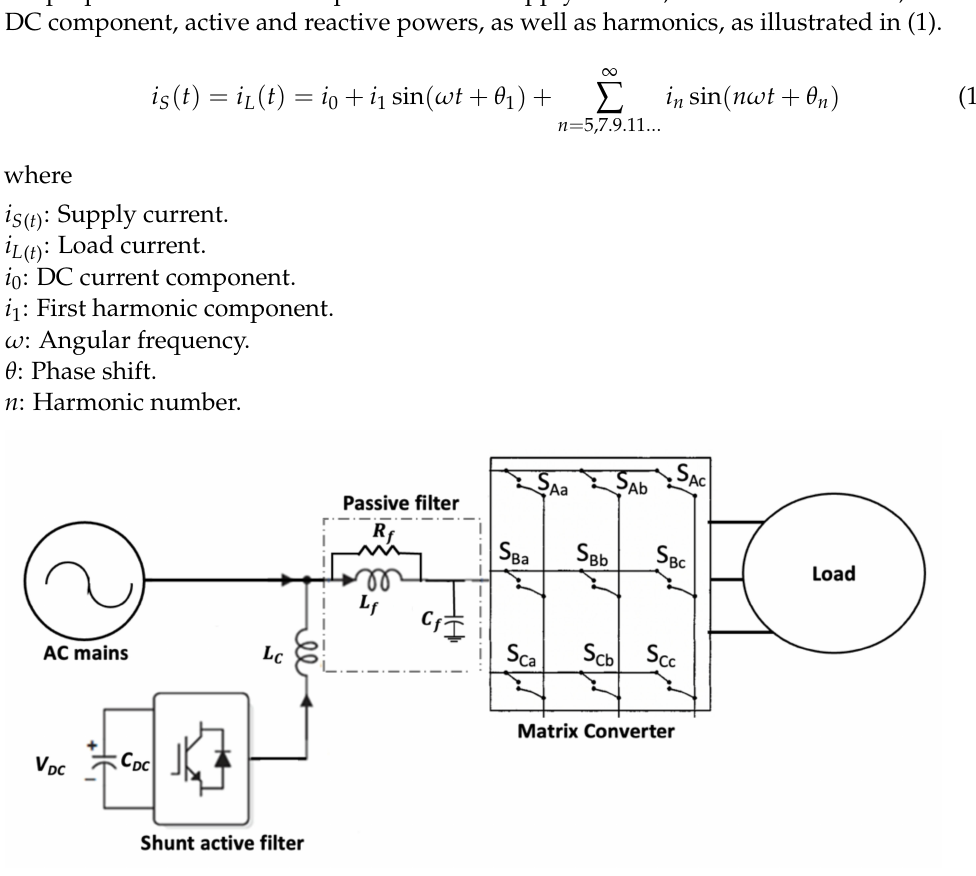
Figure 1. Proposed HAPF